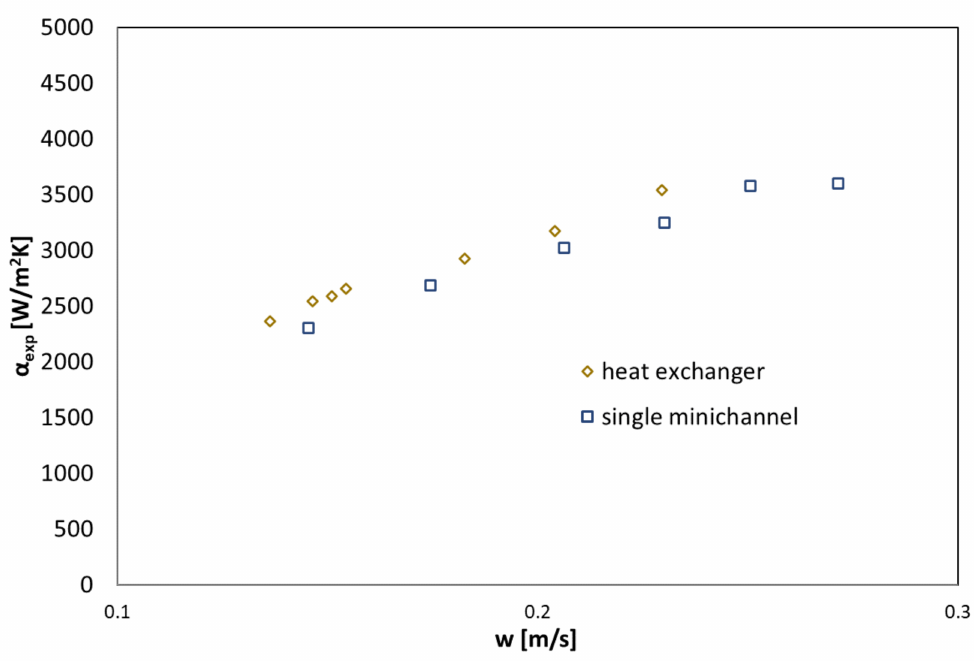
Figure 9. A comparison of experimental data of the heat transfer coefficient on the condensate velocity and condensate thickness during the HFE 7000 condensation